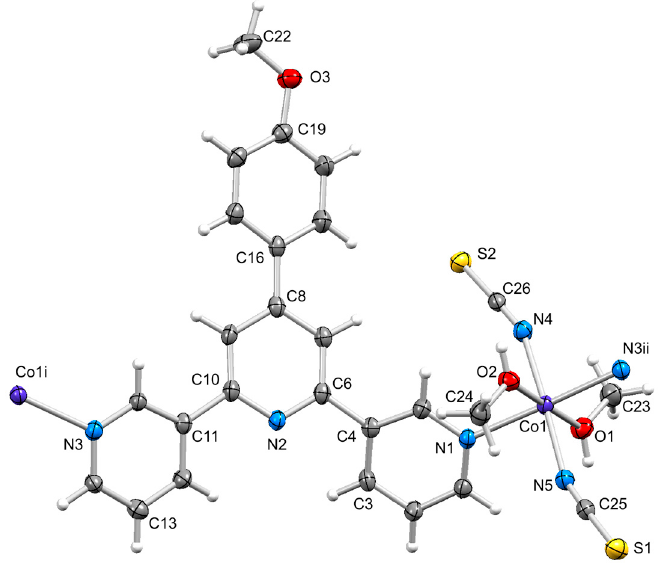
Figure 4. The repeating unit in the 1D chain of [Co( 2 )(NCS) 2 (MeOH) 2 ] n with symmetry generated atoms; ellipsoids are plotted at a 40% probability level. Symmetry codes: i = 1 / 2 – x , 1– y , – 1 / 2 + z ; ii = 1 / 2 – x ,